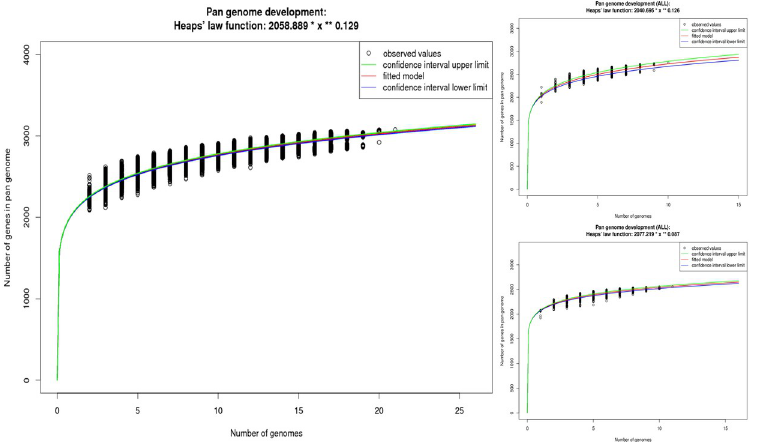
Fig 5. Pan-genome development of C . bovis . Pan-genome development using permutations of all 21 isolates of C . bovis (left); the pan-genome development of the C . bovis isolates obtained from humans and cows (upper right); and, the pan-genome development of the C . bovis isolates obtained from rodents (upper right). The red curve shows the fitted exponential Heap’s law function, blue and green curves indicate the upper and lower boundary of the 95% confidence interval.